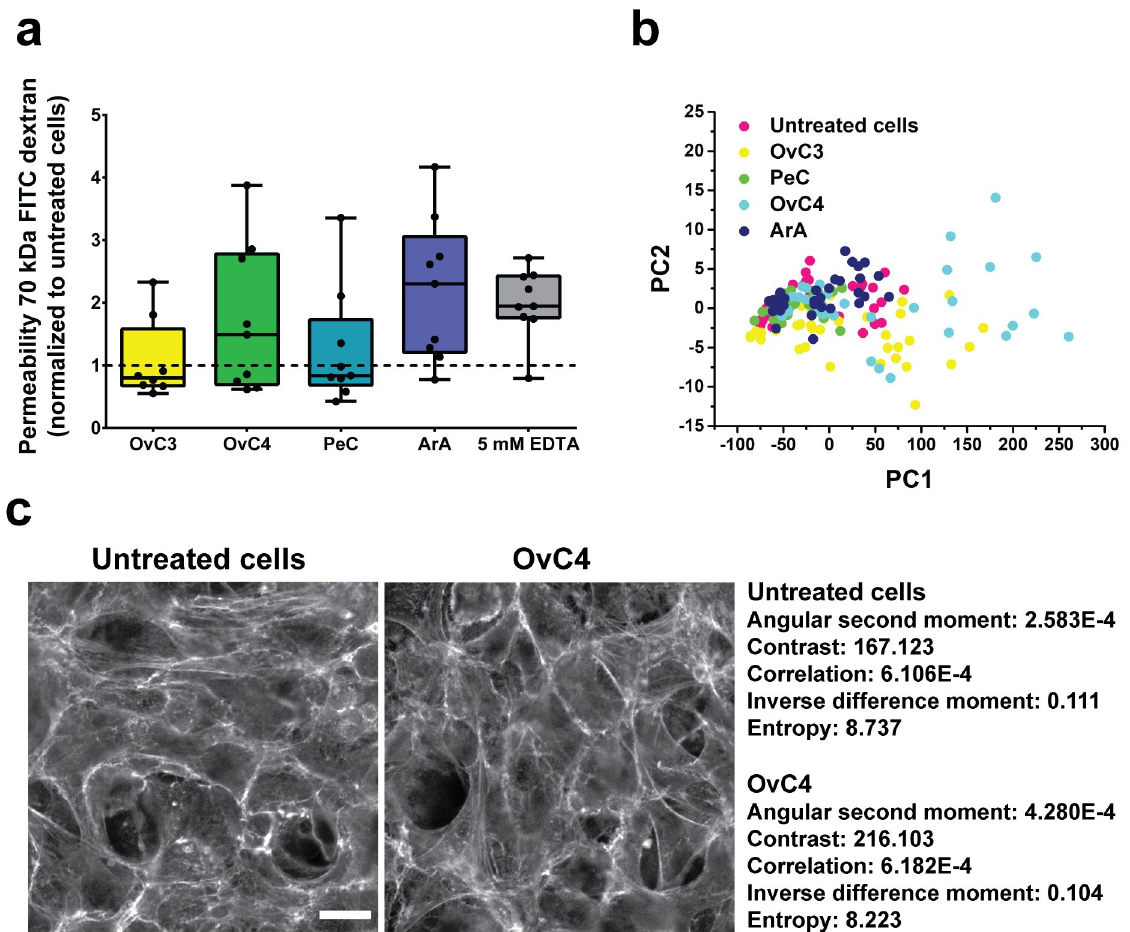
Fig 2. Permeability and F-actin texture analysis of MeT-5A cells. a) Permeability of exposed and EDTA treated (positive control) cells normalized to untreated cells (dotted line). Data are presented as median ± Min/Max, n = 3. b) PCA of F-actin texture showing the first two PCs with the highest variance. c) Example of GLCM of untreated and OvC4 treated MeT-5A cells. Scale bar is 20 μ m.